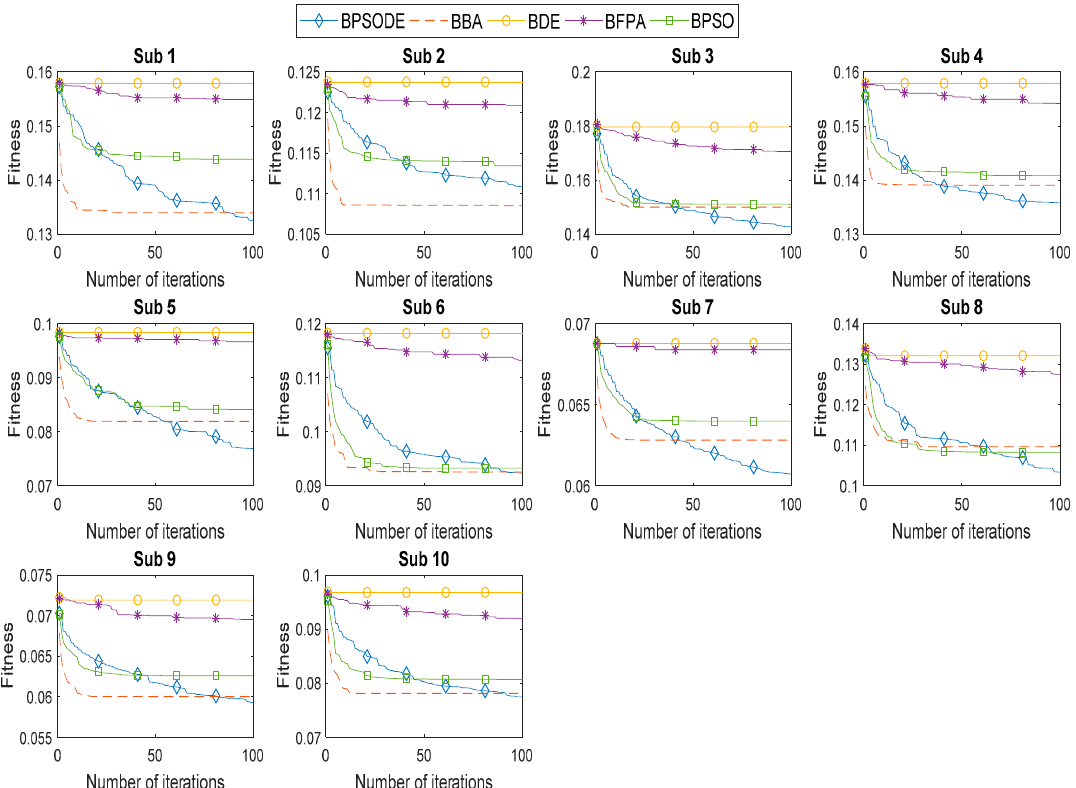
Figure 6. Convergence curves of BBA, BDE, BFPA, BPSO, and BPSODE on 10 subjects.